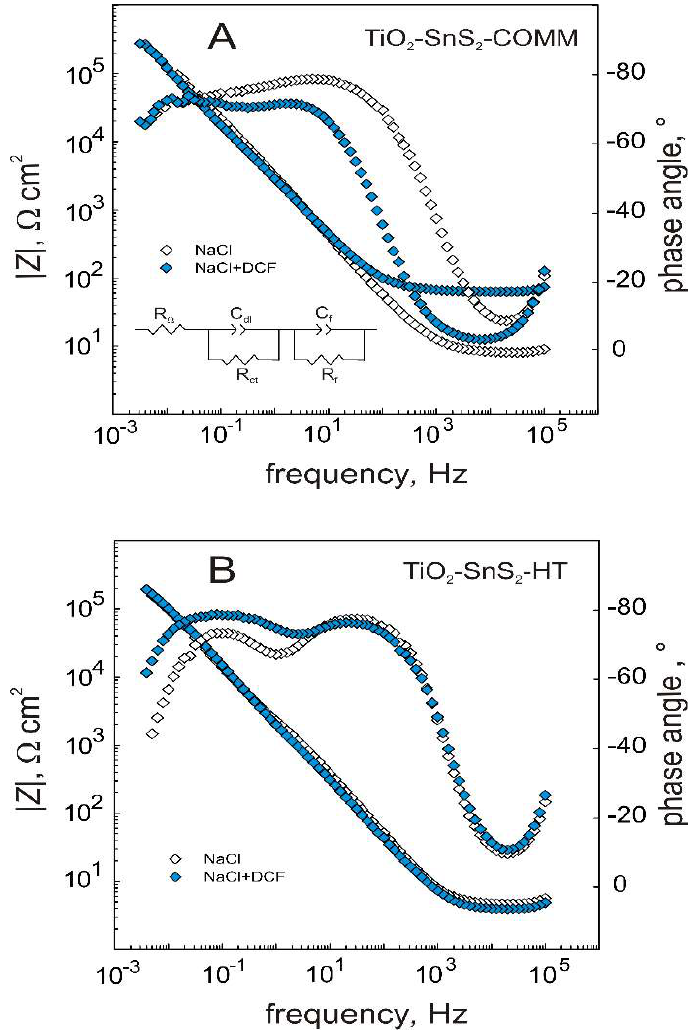
Figure 3. EIS plots of the TiO 2 -SnS 2 -COMM ( A ) and TiO 2 -SnS 2 -HT ( B ) composite films recorded in NaCl and NaCl + DCF solutions (The insert: EEC used to fit the EIS plots given). Table 4. Impedance parameters of TiO 2 -SnS 2 catalyst films recorded in NaCl and NaCl + DCF solution capacitance and resistance of the composite film, respectively) TiO 2 -SnS 2 -COMM